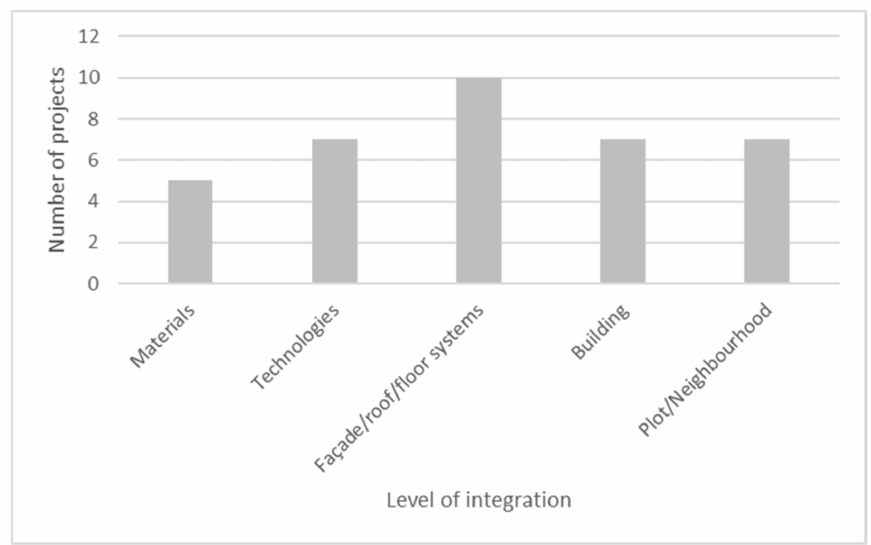
Figure 9. Integration level of the biomimetic approach.